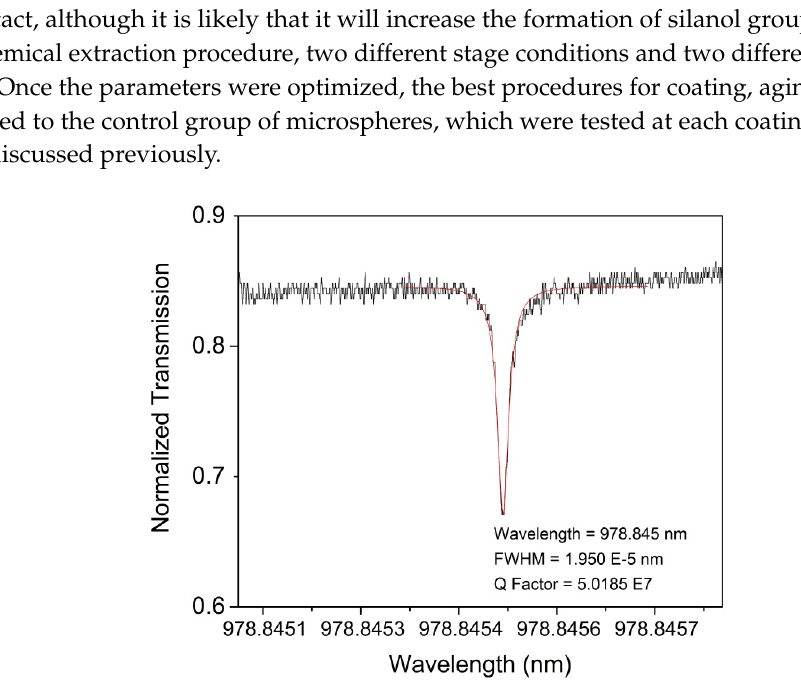
Figure 5. Q factor results of Dish 9 Sphere 1 (uncoated). Q Factors for the Dish 9 Spheres yielding consistent and high results above 10 6 Q-factor measurements. The figure depicts a peak with the Lorentzian fit ( red line) used to determine the center wavelength and full-width at half-maximum of the peak.